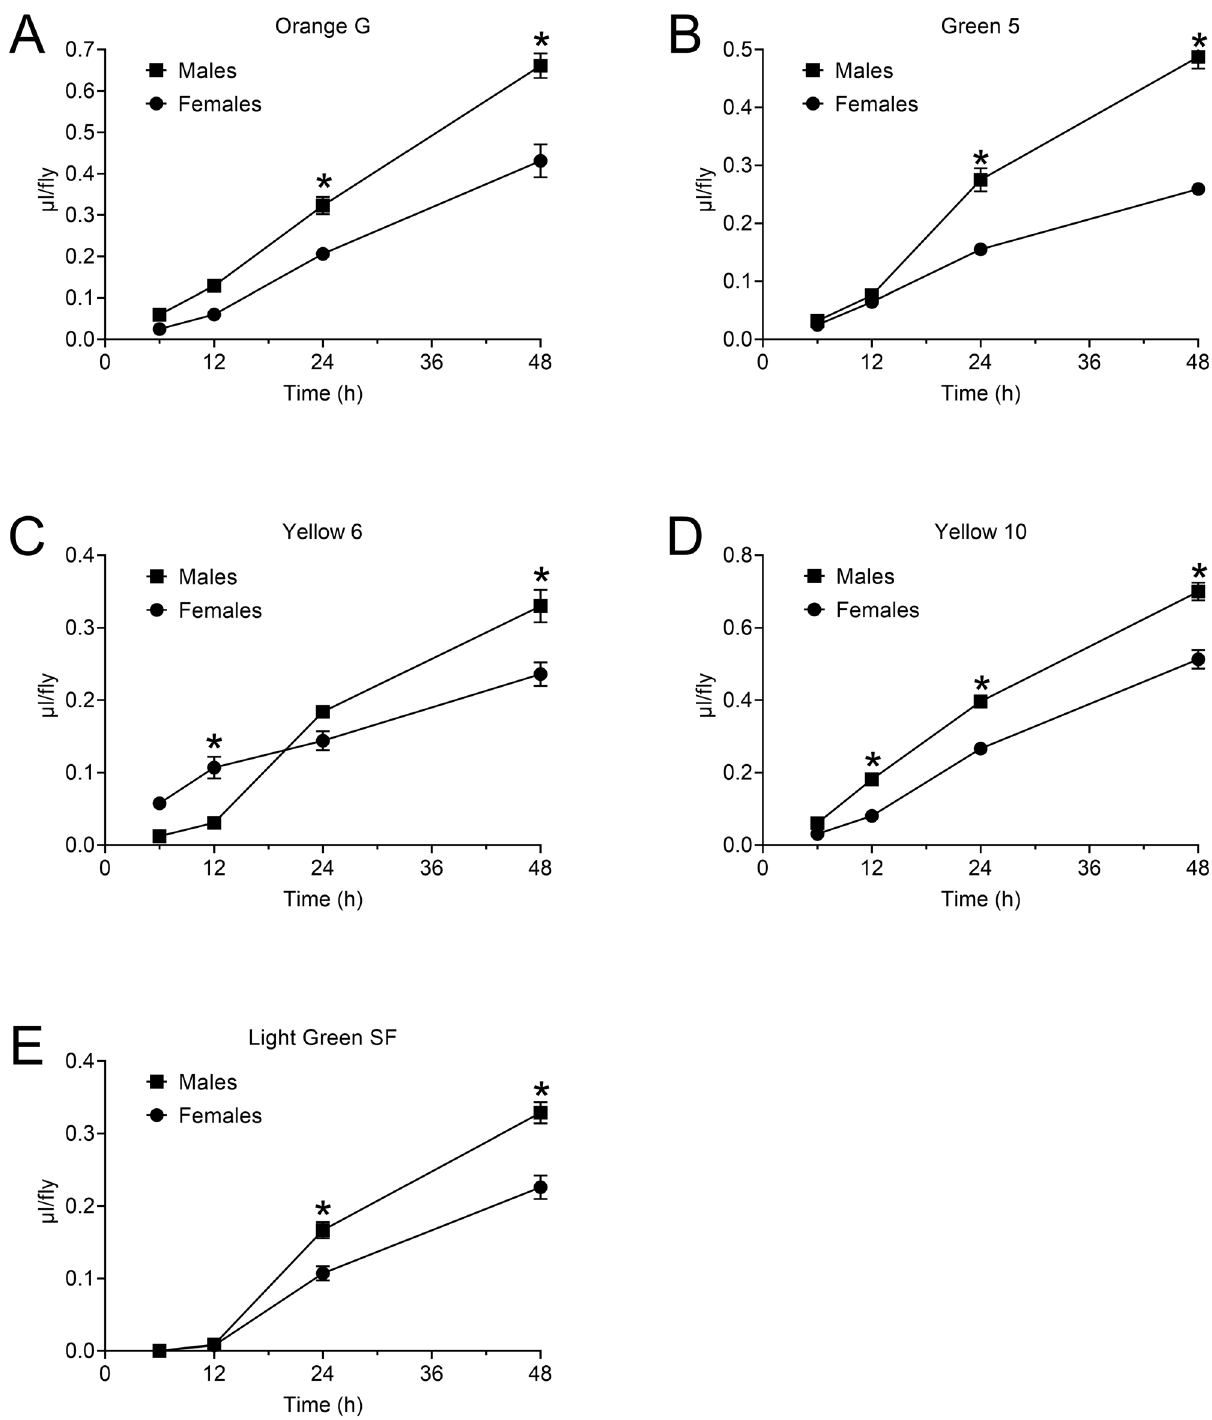
Figure 5. Con-Ex time-courses in control females and males with Orange G, Green 5, Yellow 6, Yellow 10 and Light Green SF. GL flies and 1% w/v dyes in 2Y10S3C media used in all studies. ( A – E ) Time affected Con-Ex measured with all five indicated dyes (individual two-way ANOVAs, p < 0.0001, n = 8). ( A , B , D , E ) Sex affected Con-Ex measured with Orange G, Green 5, Yellow 10 and Light Green SF (individual two-way ANOVAs, p < 0.0001). ( C ) Sex did not affect Con-Ex determined with Yellow 6 (two-way ANOVA, p = 0.7247). ( A – E ) There were interactions between time and sex in all experiments (individual two-way ANOVAs, p < 0.0001). Con-Ex was significantly different in females and males at the indicated time-points (*Bonferroni’s, p = 0.0005 to < 0.0001). Data are mean ±